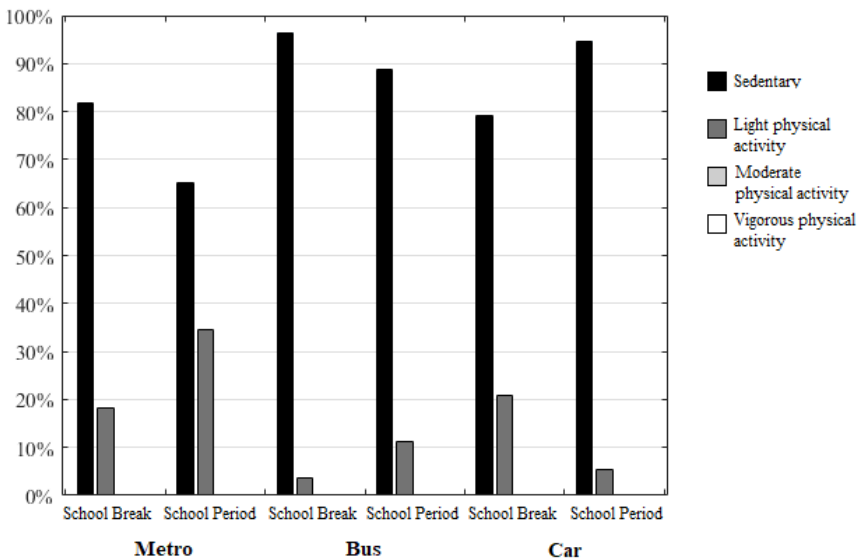
Figure 7. Metabolic equivalents of task measurements during school break and school periods based on heart rate measurements. The graphic represents the percentage of metabolic equivalent of task (MET) data that belong in each category for each corresponding period. The classification of the commuting activity is divided into categories: sedentary (<2 MET), light (2–3 MET), moderate (3–6 MET) and vigorous (>6 MET)